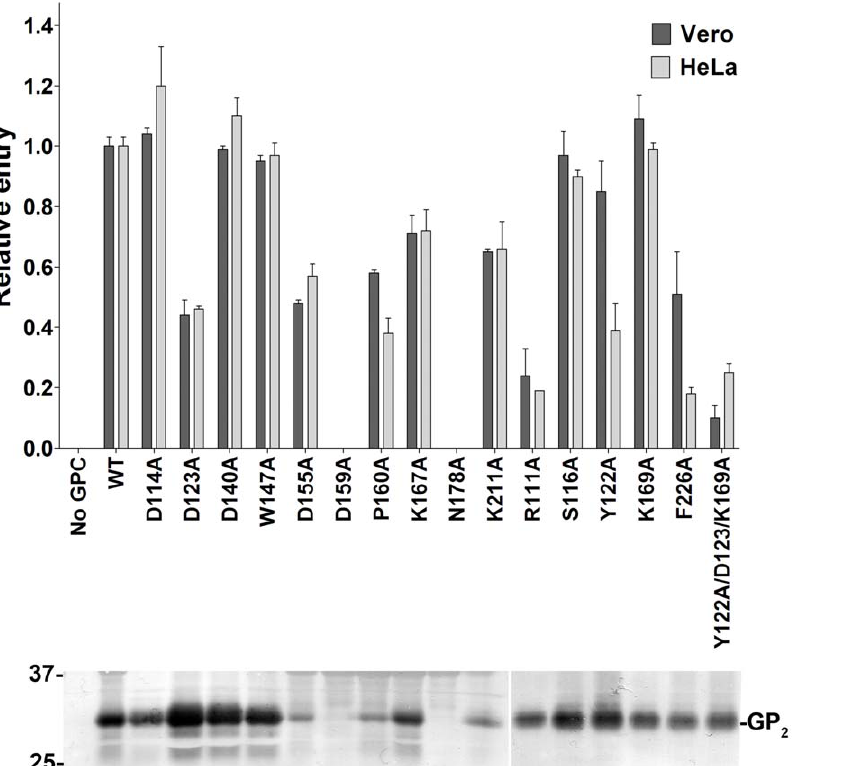
Figure 3. Cell transduction efficiency of eGFP-expressing retrovirus pseudotyped with wild-type MACV GPC, or variants thereof (grey bars, HeLa cells; black bars, Vero cells). This assay was performed twice in triplicates yielding similar results. Bars indicate average of triplicates in one representative experiment. A representative western blot analysis of the various MoMLV pseudotypes is shown using an antibody against MACV GP2. The numbers to the left of the blots indicate relative molecular mass in kDa.